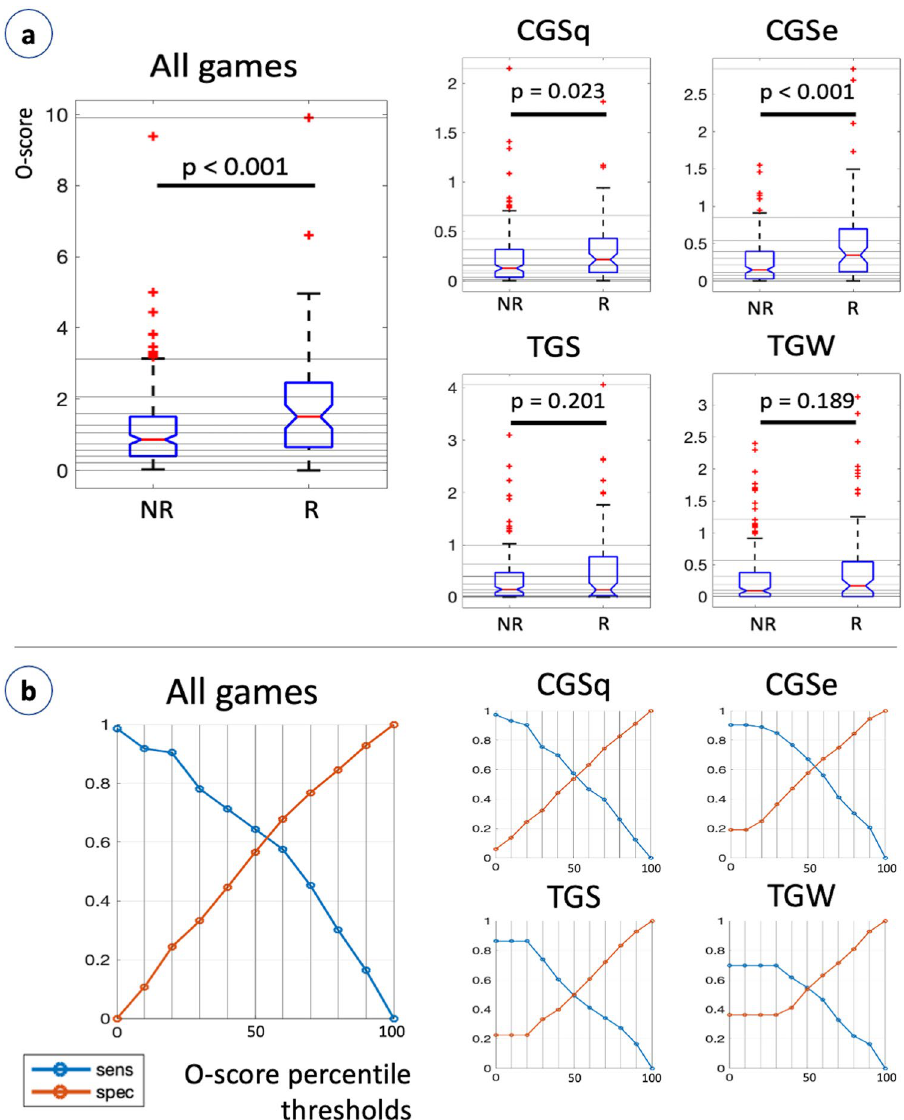
Figure 3. ( a ) O-score, stratified by risk. Red horizontal line: median; box: inter quartile range; notch: median 95% confidence interval; red crosses: outliers. The same graph is repeated considering all games together and each game separately. ( b ) Sensitivity and specificity at the different percentile thresholds. The same graph is repeated considering all games together and each game